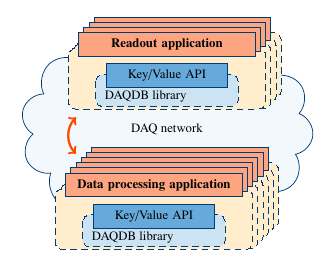
Figure 3. Base deployment model. Figure 4. Deployment model with detached